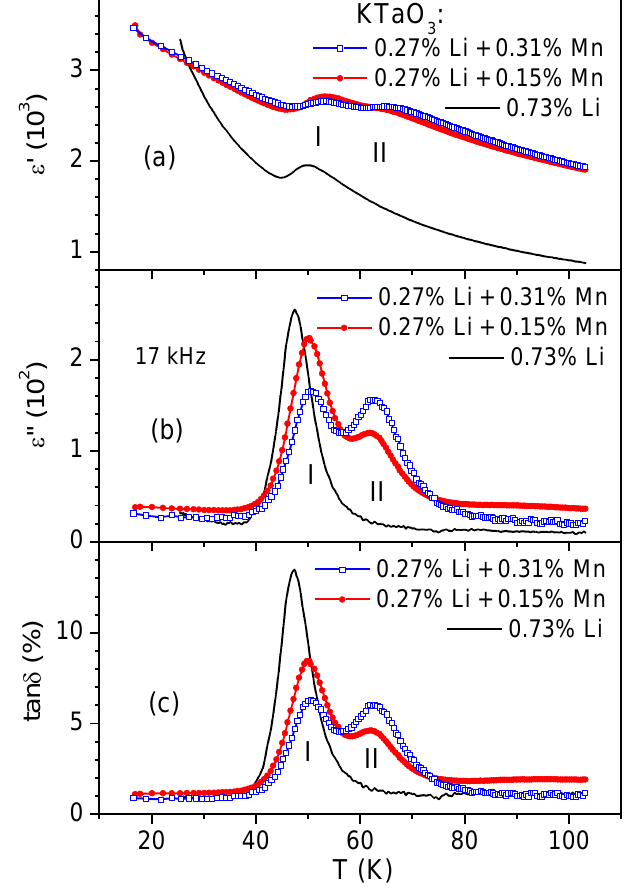
Figure 1. Real ε ’ ( a ) and imaginary ε ’’ ( b ) parts of the dielectric permittivity and dissipation factor tanδ ( c ) of KTaO 3 : 0.73% Li (solid line), KTaO 3 : 0.27% Li and 0.15% Mn (open squares) and KTaO 3 : 0.27% Li and 0.31% Mn (solid circles) single crystals as a function of temperature T at about 17 kHz.